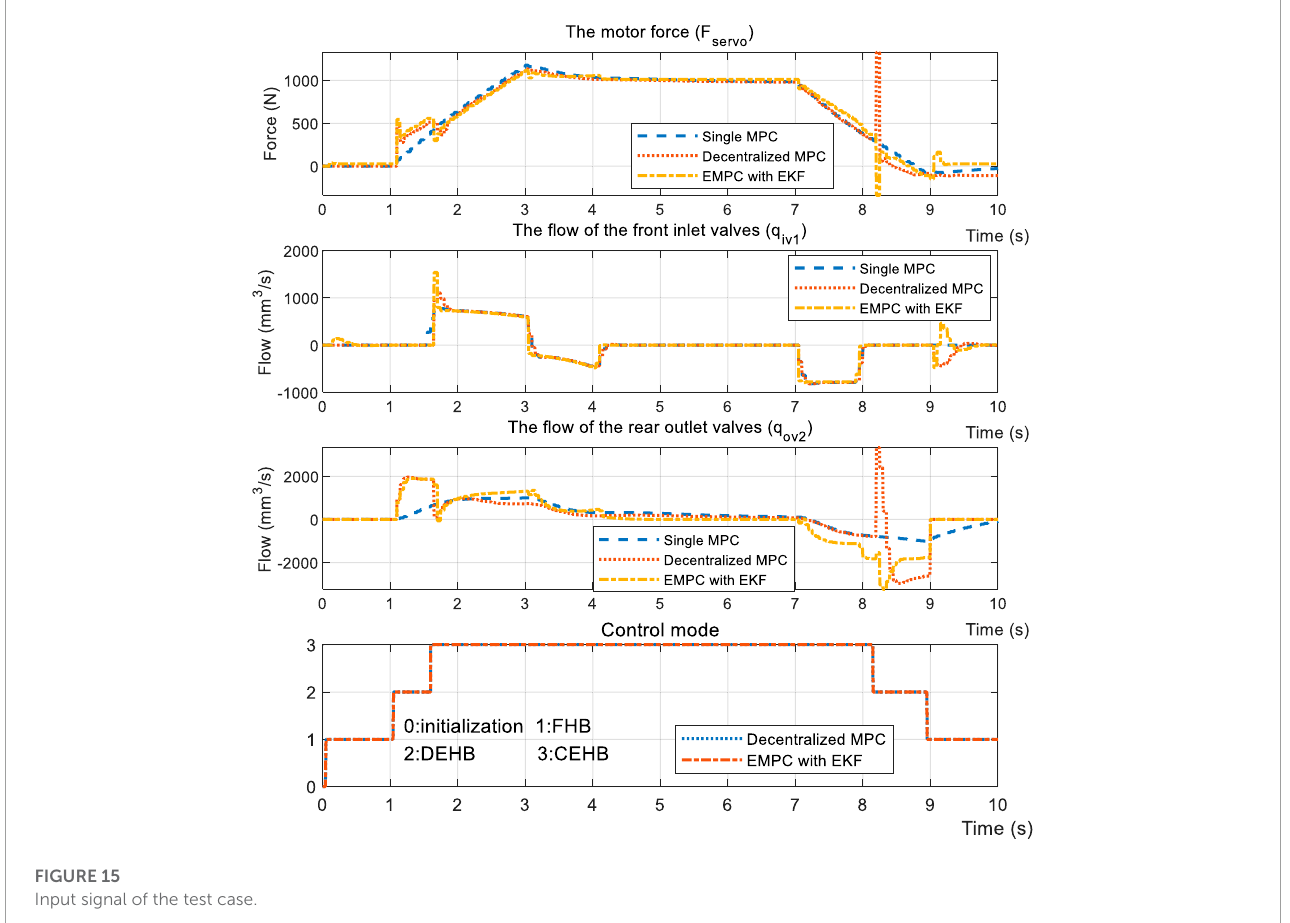
FIGURE 15 Input signal of the test